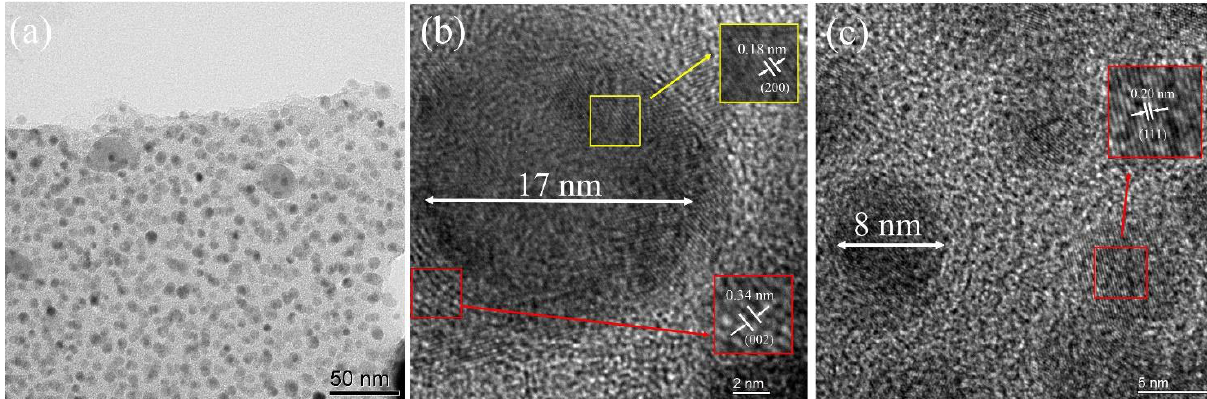
Figure 2. FESEM images of ( a ) NC/Ni-0.25M, ( b ) NC/Ni-0.5M, ( c ) NC/Ni-0.75M, ( d ) NC/Ni-1M.